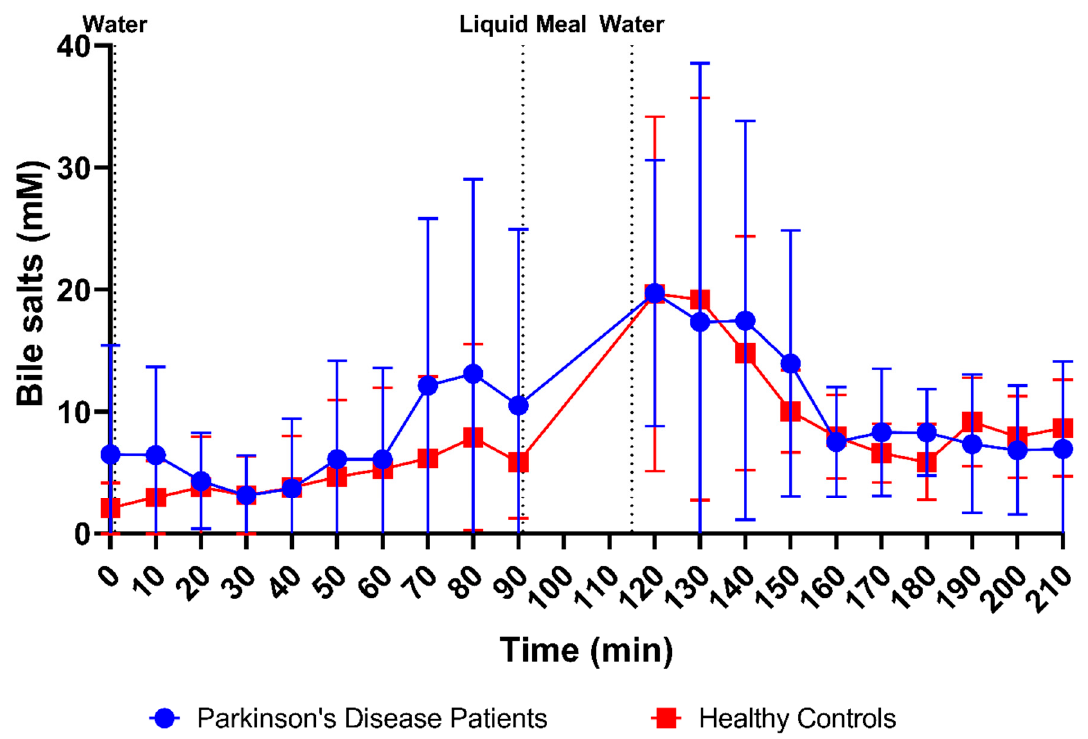
Figure 9. Time-dependent evolution of the total bile salt concentration in duodenal fluids aspirated from Parkinson’s disease patients ( n = 9, blue circles) and healthy controls ( n = 9, red squares). Data points represent the mean ± standard deviation; vertical dotted lines indicate the ingestion of 100 mL of water or 200 mL of liquid meal.